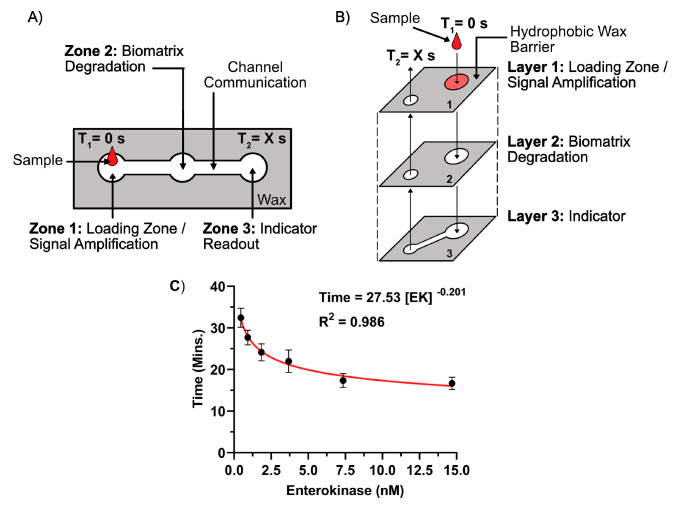
Figure 1. Overview of the chronometric quantitation mechanism on a simple microPAD design. ( A ) Lateral flow design on a 2D microPAD and ( B ) vertical flow design on a 3D microPAD